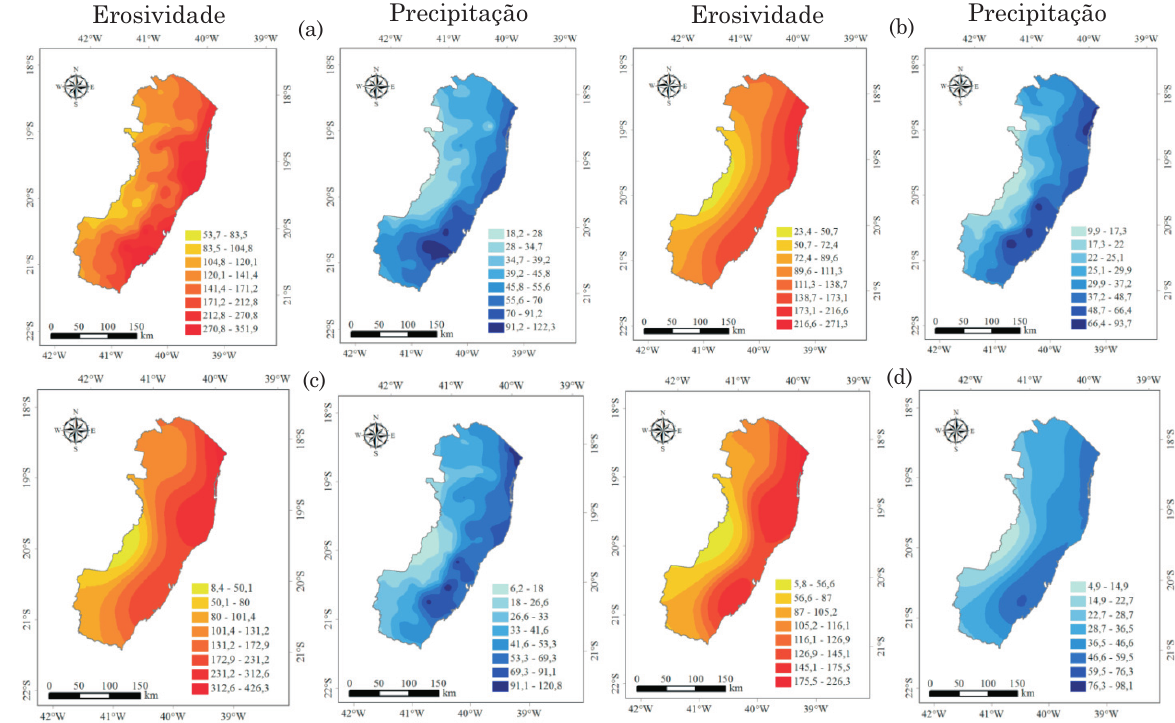
Figura 9. Mapas de erosividade (MJ ha -1 mm h -1 ano -1 ) e precipitação (mm), ambos mensais, para o Estado do Espírito Santo (a) maio; (b) junho; (c) julho; (d)